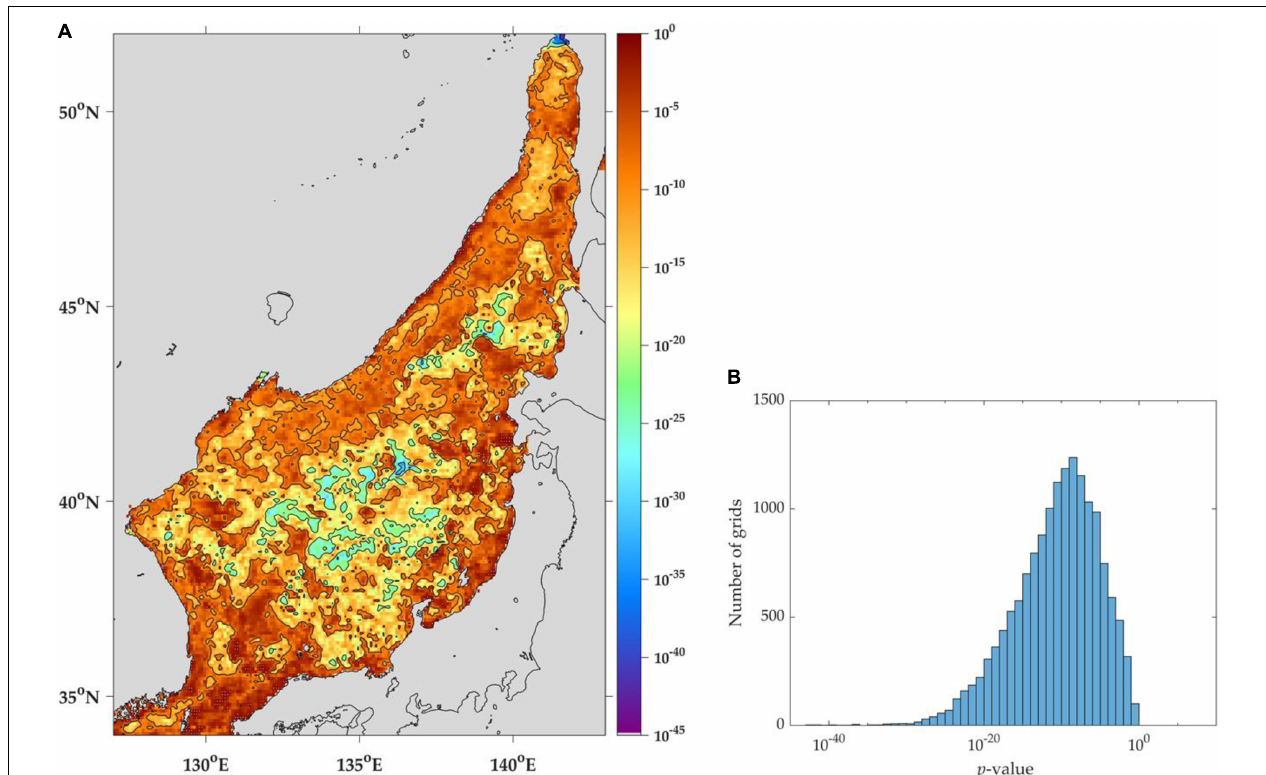
FIGURE 2 | Spatial distribution of (A) statistical significance ( p -values), based on multi-variate regression, of chlorophyll- a concentration data and (B) histogram of the p -values. Only a few statistically insignificant pixels ( p -value < 0.05) are marked as gray dots in (A) .